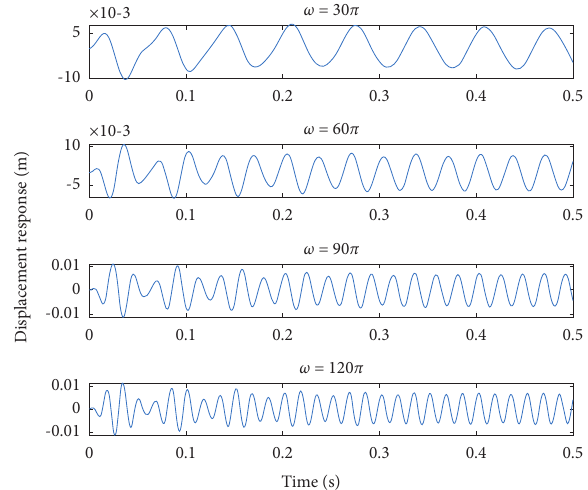
Figure 12: Response of beams under different excitation frequencies.